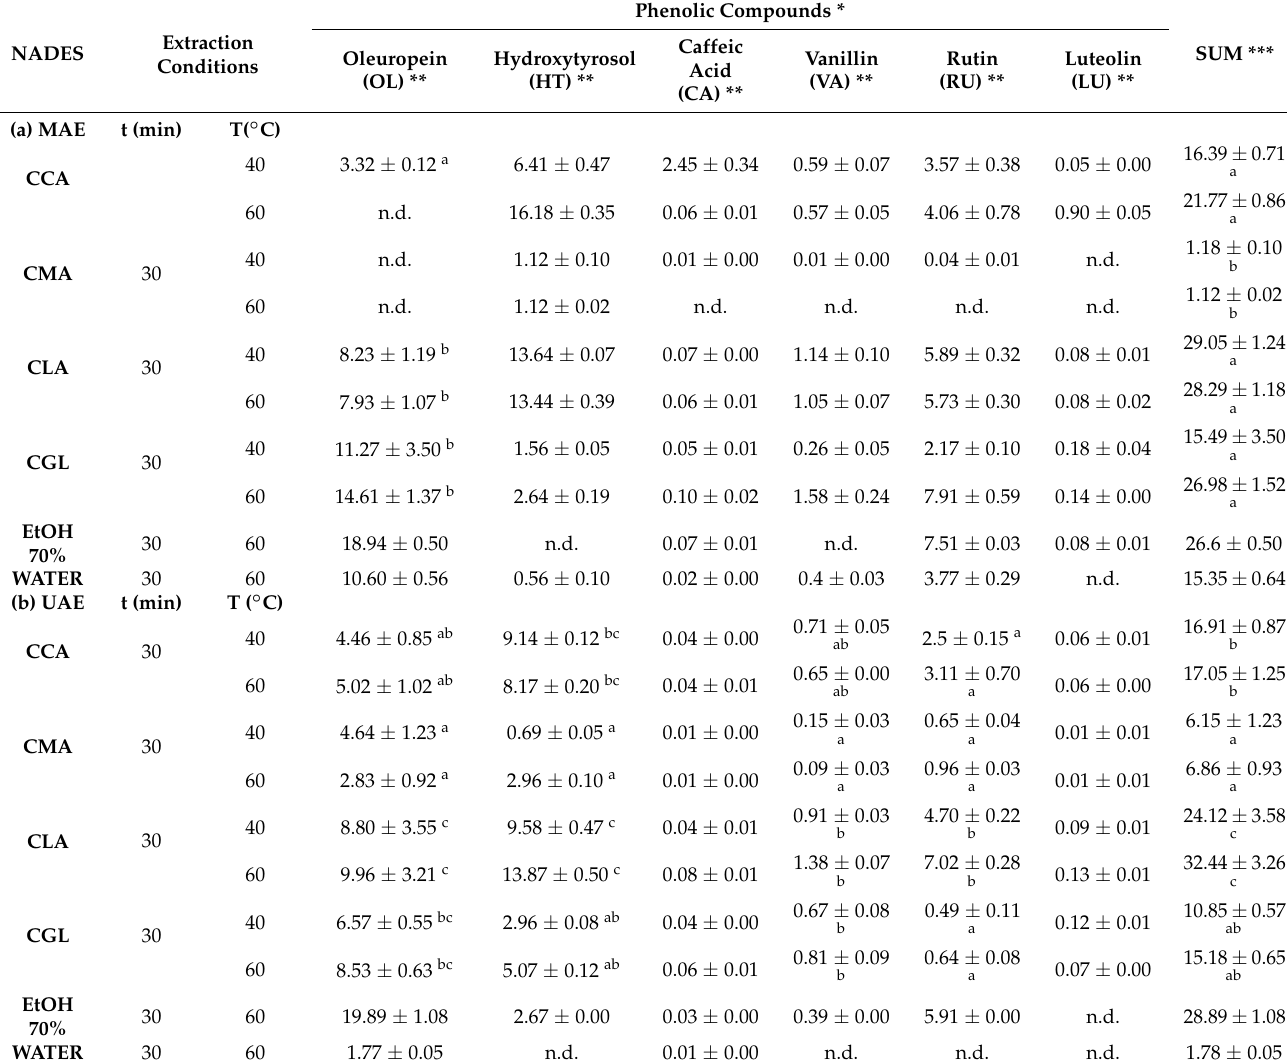
Table 2. Effect of NADES on the identified phenolic compounds (using HPLC) extracted from olive leaves using MAE (a) and UAE (b) and comparison with conventional